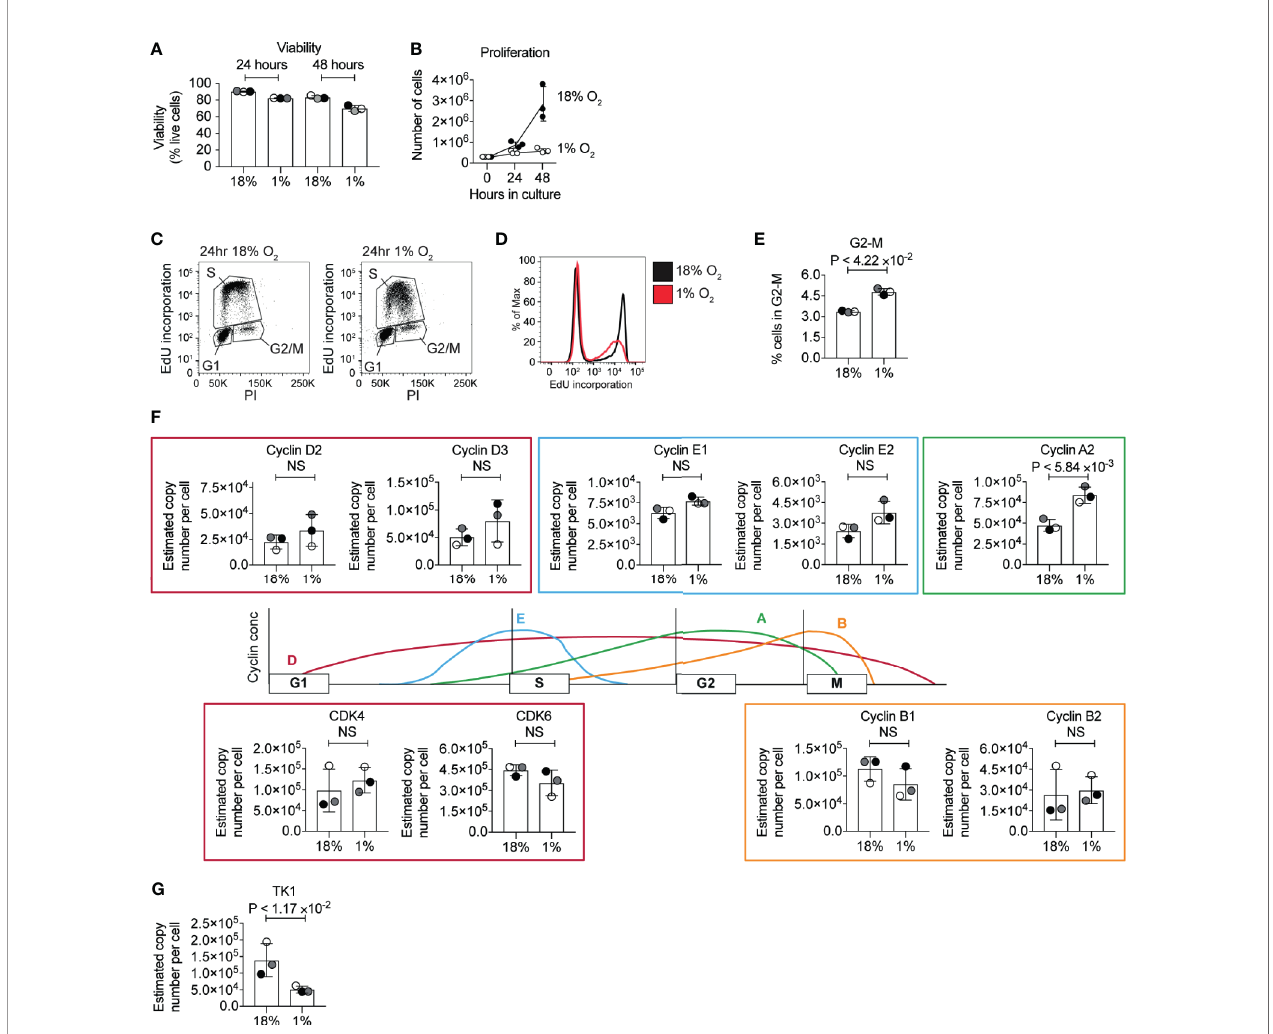
FIGURE 4 | Inhibition of the cell cycle by hypoxia. (A) Viability of CTL maintained in normoxia or subjected to hypoxia for 24 hours or 48 hours as determined by fl ow cytometry forward scatter (FSC) and side scatter (SSC) and DAPI staining. (B) Proliferation of CTLs in normoxia or hypoxia over 48 hours. (C – E) Flow cytometric analysis of cell cycle stages in CTLs maintained in normoxia or after 24 hours of hypoxia using EdU incorporation into DNA. Representative fl ow plots of DNA stained with PI against EdU incorporation are shown in (C) , and a histogram of EdU incorporation alone is shown in (D) . The percentage of CTL identi fi ed as in G2 is shown in (E) . (F) Schematic representation of selected cyclin levels during the cell cycle, with bar charts showing copy numbers estimated from the proteomic data for the indicated cyclins and CDKs shown alongside. (G) Copy numbers for thymidine kinases estimated from the proteomic data. Data in (A, B) and (E – G) show three biological replicates. Data in (C, D) are representative of three biological replicates. In bar charts, data points from individual biological replicates are shown and are colour matched, the bar shows the mean and the error bars show standard deviation. P values were calculated using a two-tailed paired t-test. Non-signi fi cant changes are marked